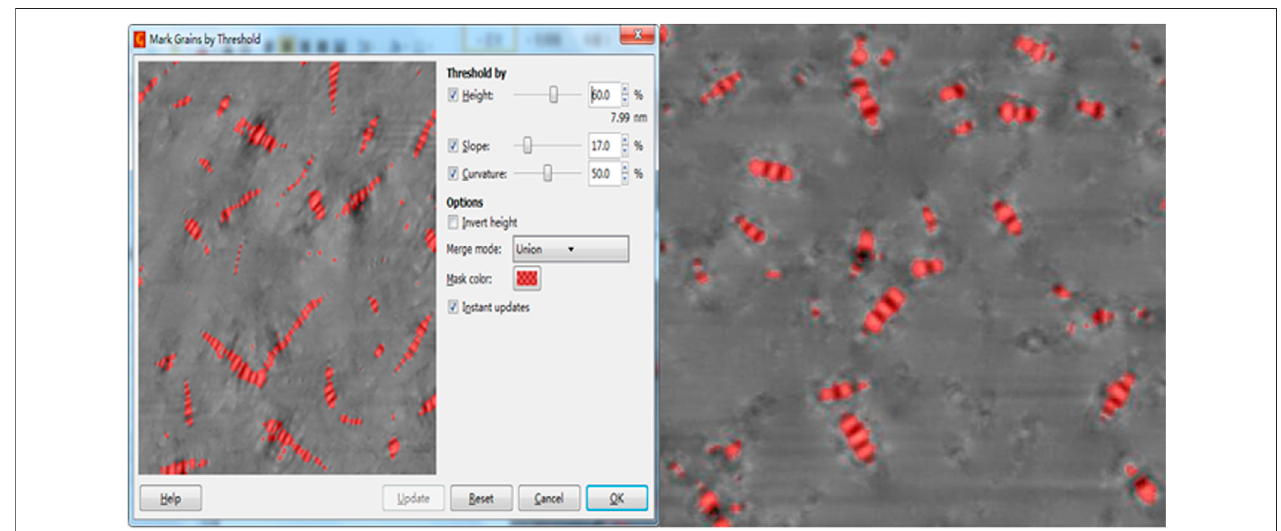
FIGURE 6 | Labeled asphalt topography. (A) Gwyddion software “ honeycomb ” structure marker. (B) Mark “ honeycomb ”